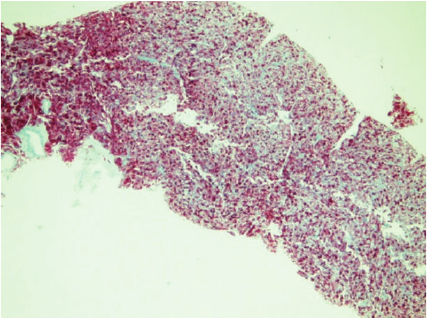
Figure 6: HMB-45